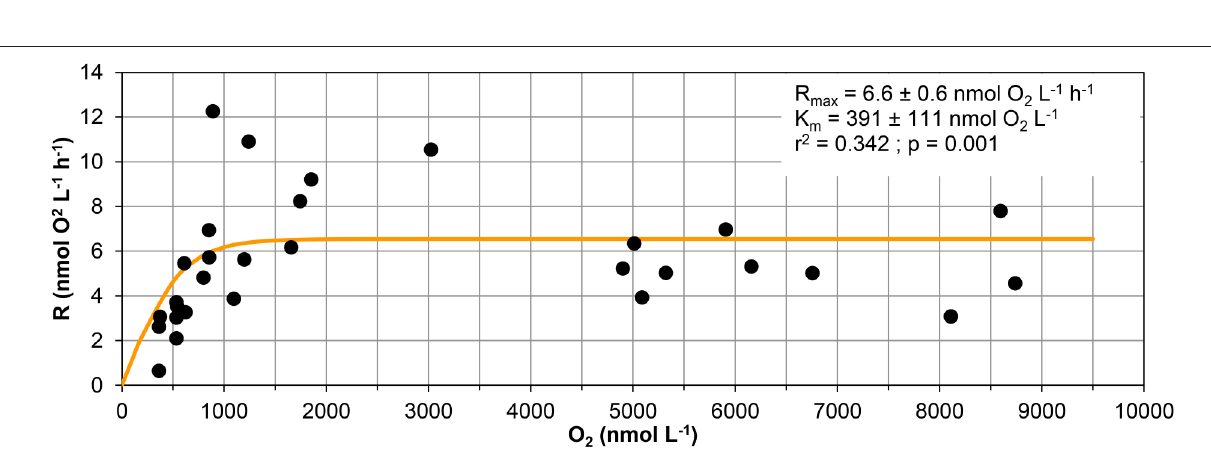
FIGURE 4 | Respiration and active microbial growth profiles measured in Golfo Dulce at station GD-1 (19 of January 2015) and GD-2 (22 of January 2015). Data were modeled as described in the text and shown in Figure 1 in order to calculate: initial respiration rate ( R 0 ) and maximum respiration rate during the incubation ( R *), lag-phase ( λ ), and maximum growth rate ( µ m ) of the microbial activity in the bottles during the incubation. K m was only calculated at 20m depth, being 39 ± 1nmol O 2 L − 1 . Note the different scale for R 0 and R *.